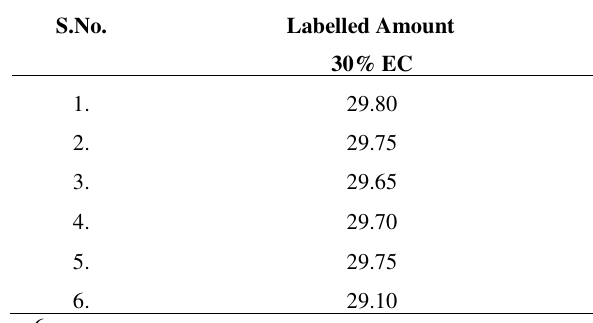
Labelled Amount